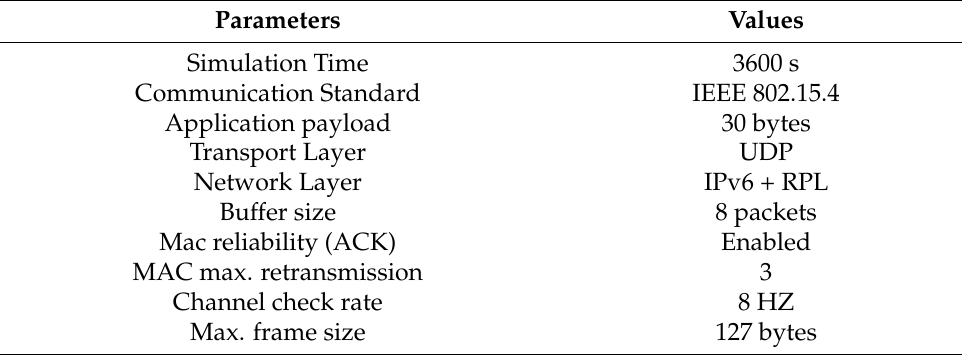
Table 5. Simulation Parameters of wireless